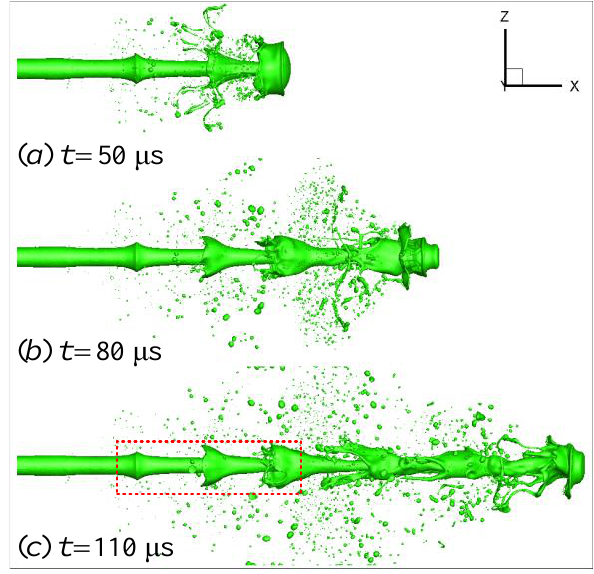
Figure 7. Evolution of jet surface waves at f = 66.6 kHz.